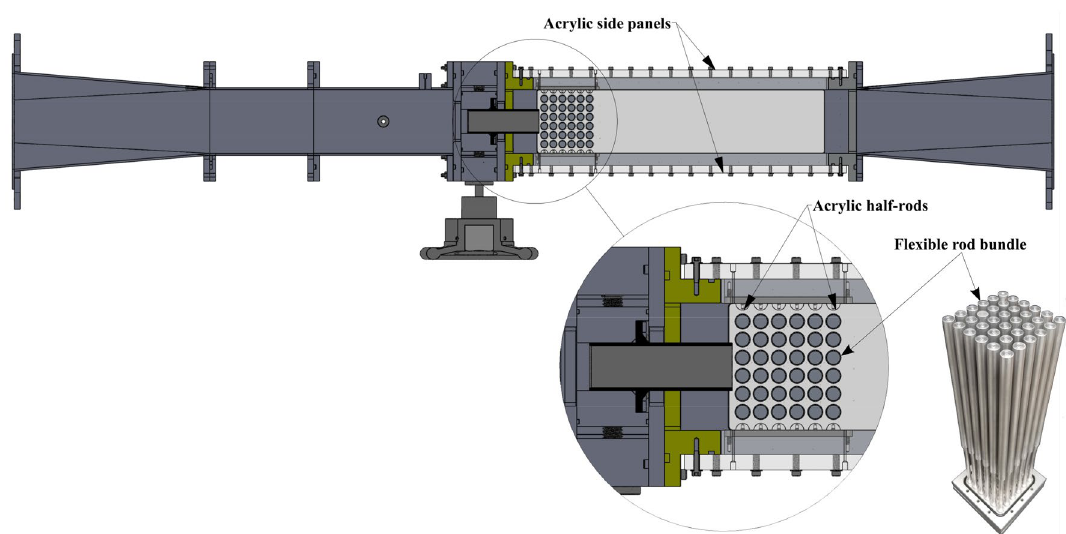
Figure 3. Experimental